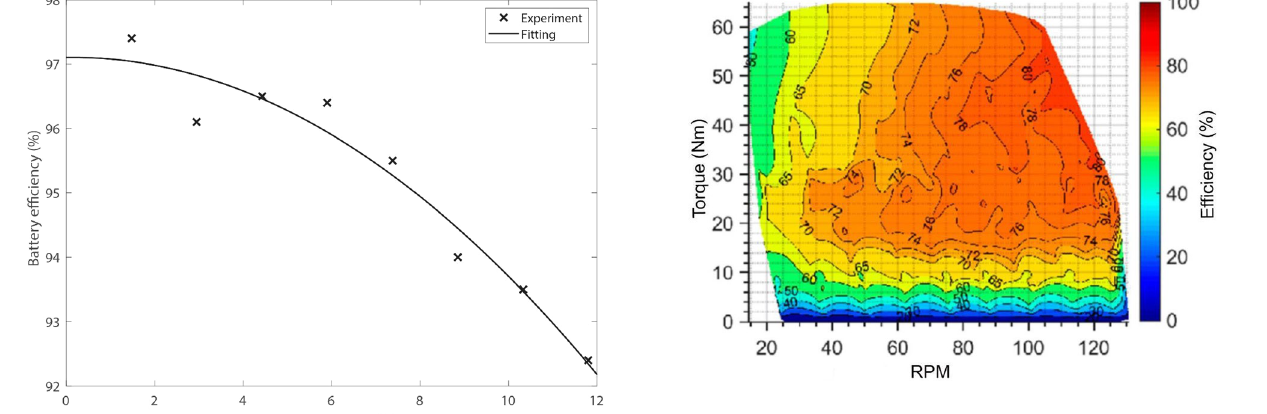
Fig. 10 Efficiency map of the power unit